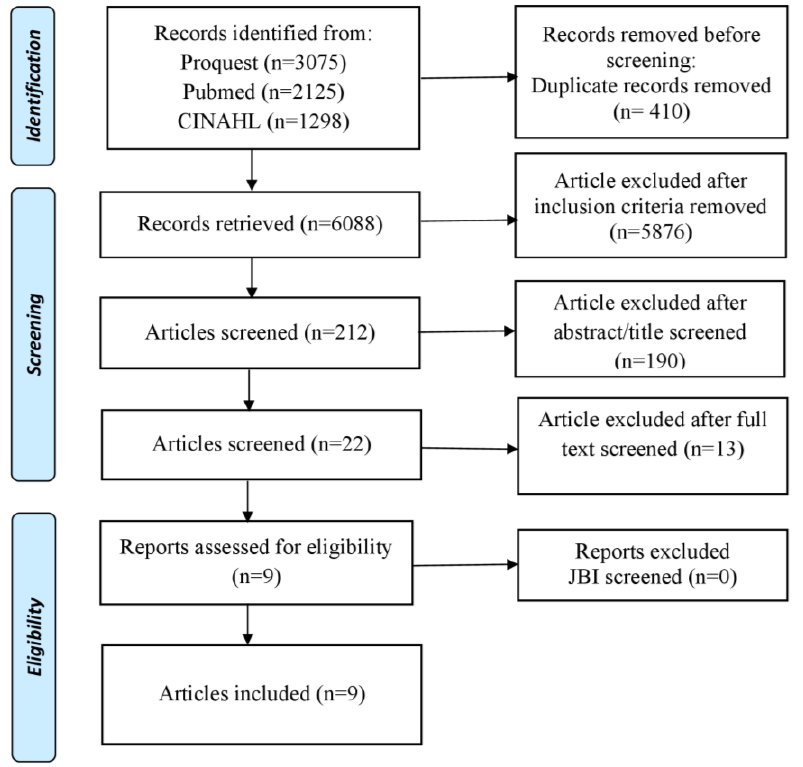
Figure 1. PRISMA flow